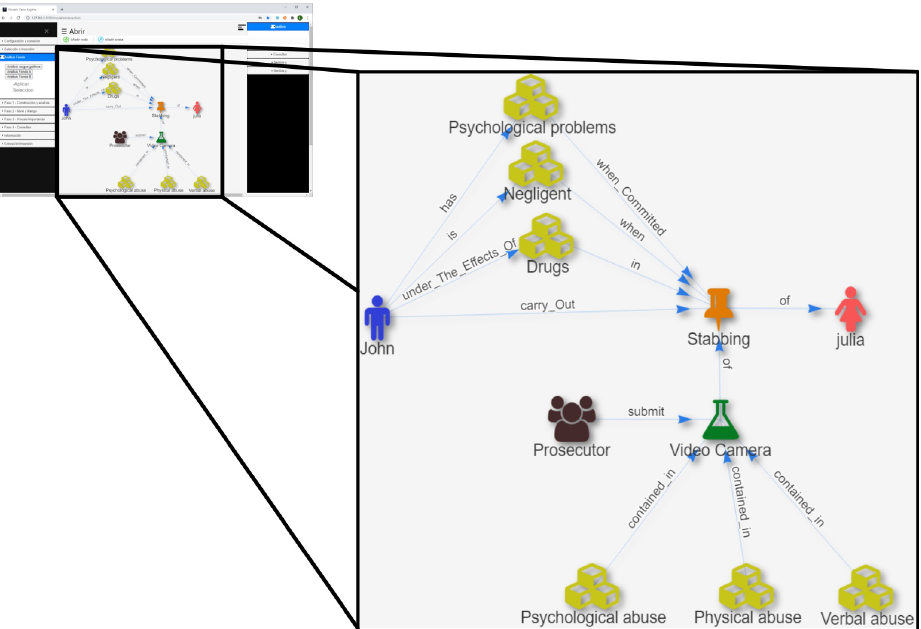
Figure 3. EGI: The graphic arrangement of images according to the interpretation and assessment of a judge on a simplified legal scenario related to a stabbing in a homicide case.